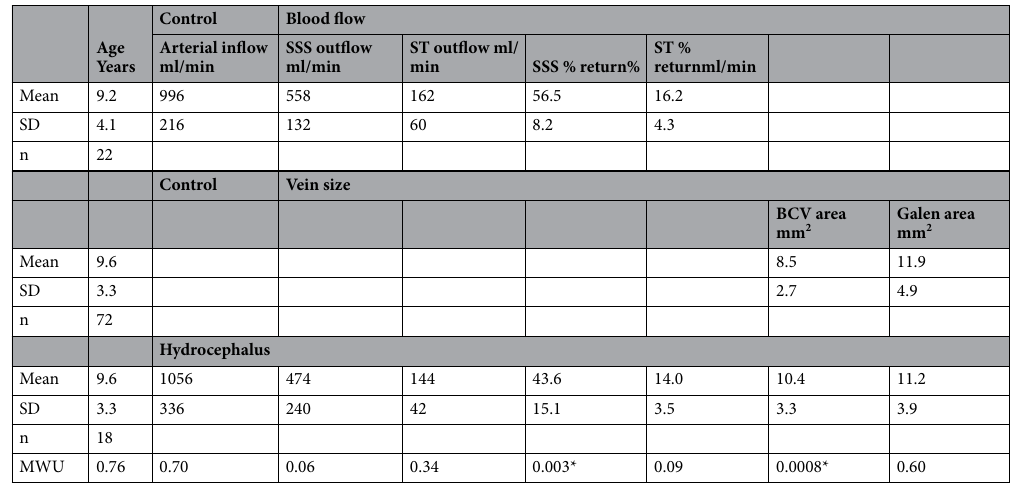
Table 1. Blood flow and vein size. BCV bridging cortical vein, ml/min milliliters per minute, mm2 millimeters squared, MWU Mann–Whitney U test, SD standard deviation, SSS superior sagittal sinus, ST straight sinus; *significance <